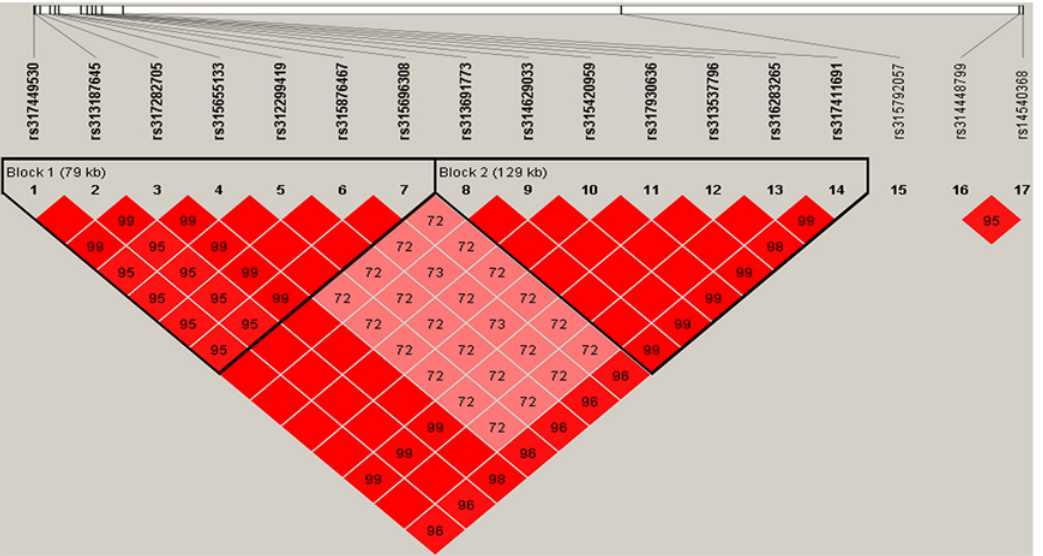
Fig 5. Linkage disequilibrium (r2) plot for associations with egg number betwwen 21 and 40 weeks. Solid lines mark the identified blocks. doi:10.1371/journal.pone.0140615.g005 PLOS ONE | DOI:10.1371/journal.pone.0140615 October 23,